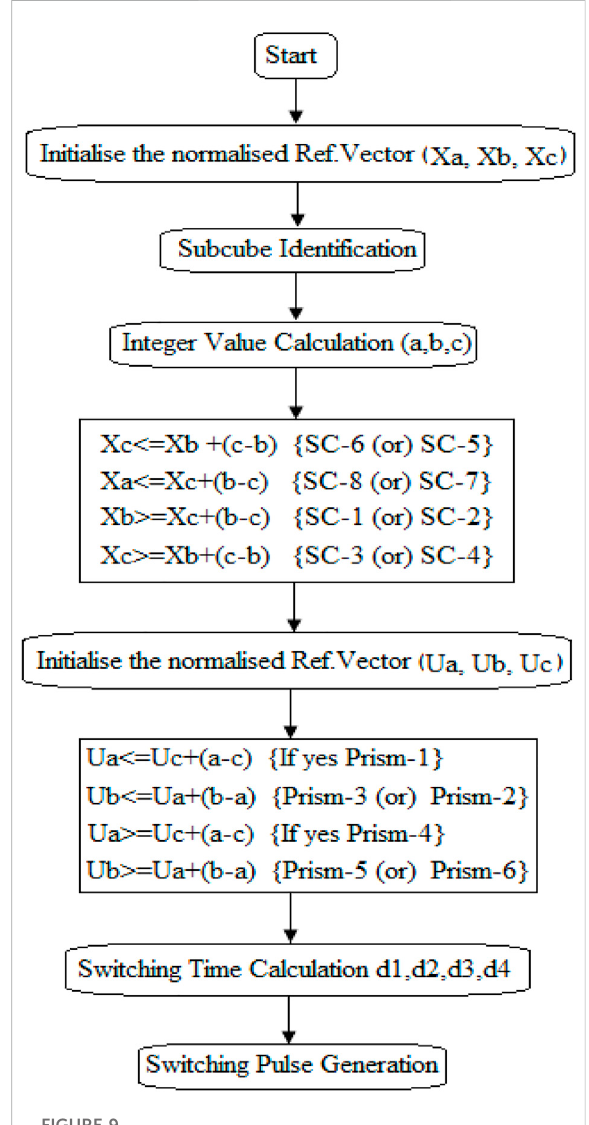
FIGURE 9 Flowchart for the process involved in NSV —